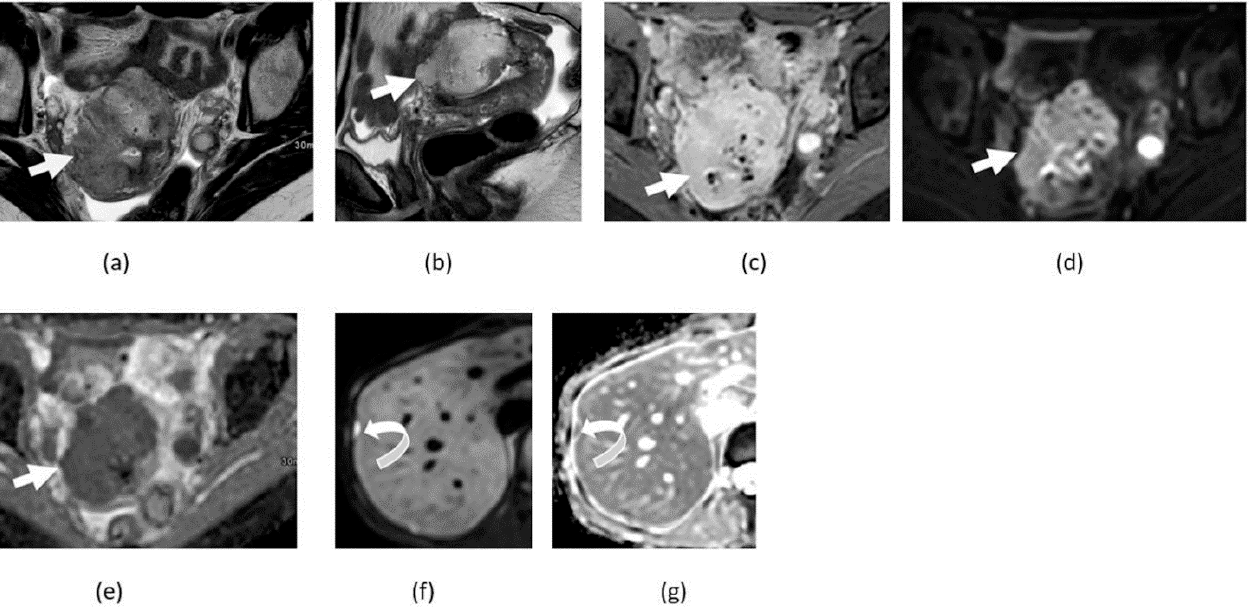
Figure 3. Axial T2-weighted ( a ), contrast-enhanced T1-weighted ( b ), DWI ( c ), and ADC map ( d ) image shows a large T2 heterogenous uterine fibroid with peripheral cellular area showing diffusion restriction (arrows) and central T2 hyperintense non-enhancing area without diffusion restriction in the degenerated portion (asterisk) of the fibroid.